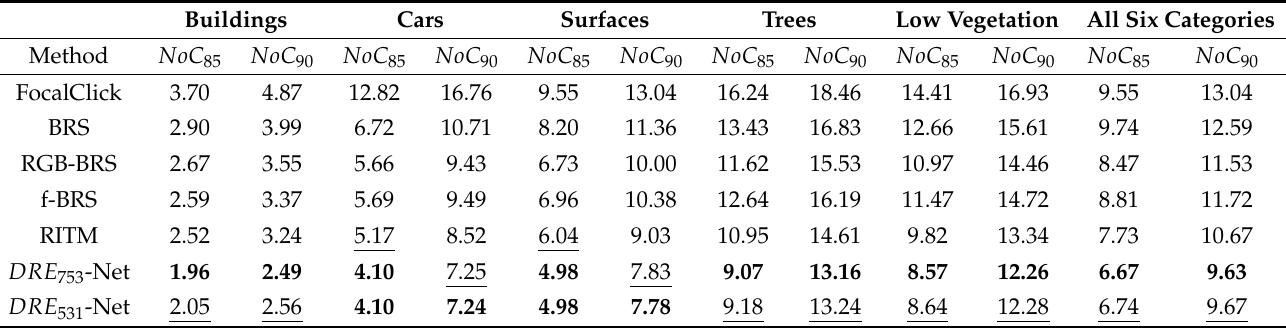
Table 2. Comparison of the NoC 85 and NoC 90 on the Potsdam dataset. (The best is bolded and the runner-up is underlined).